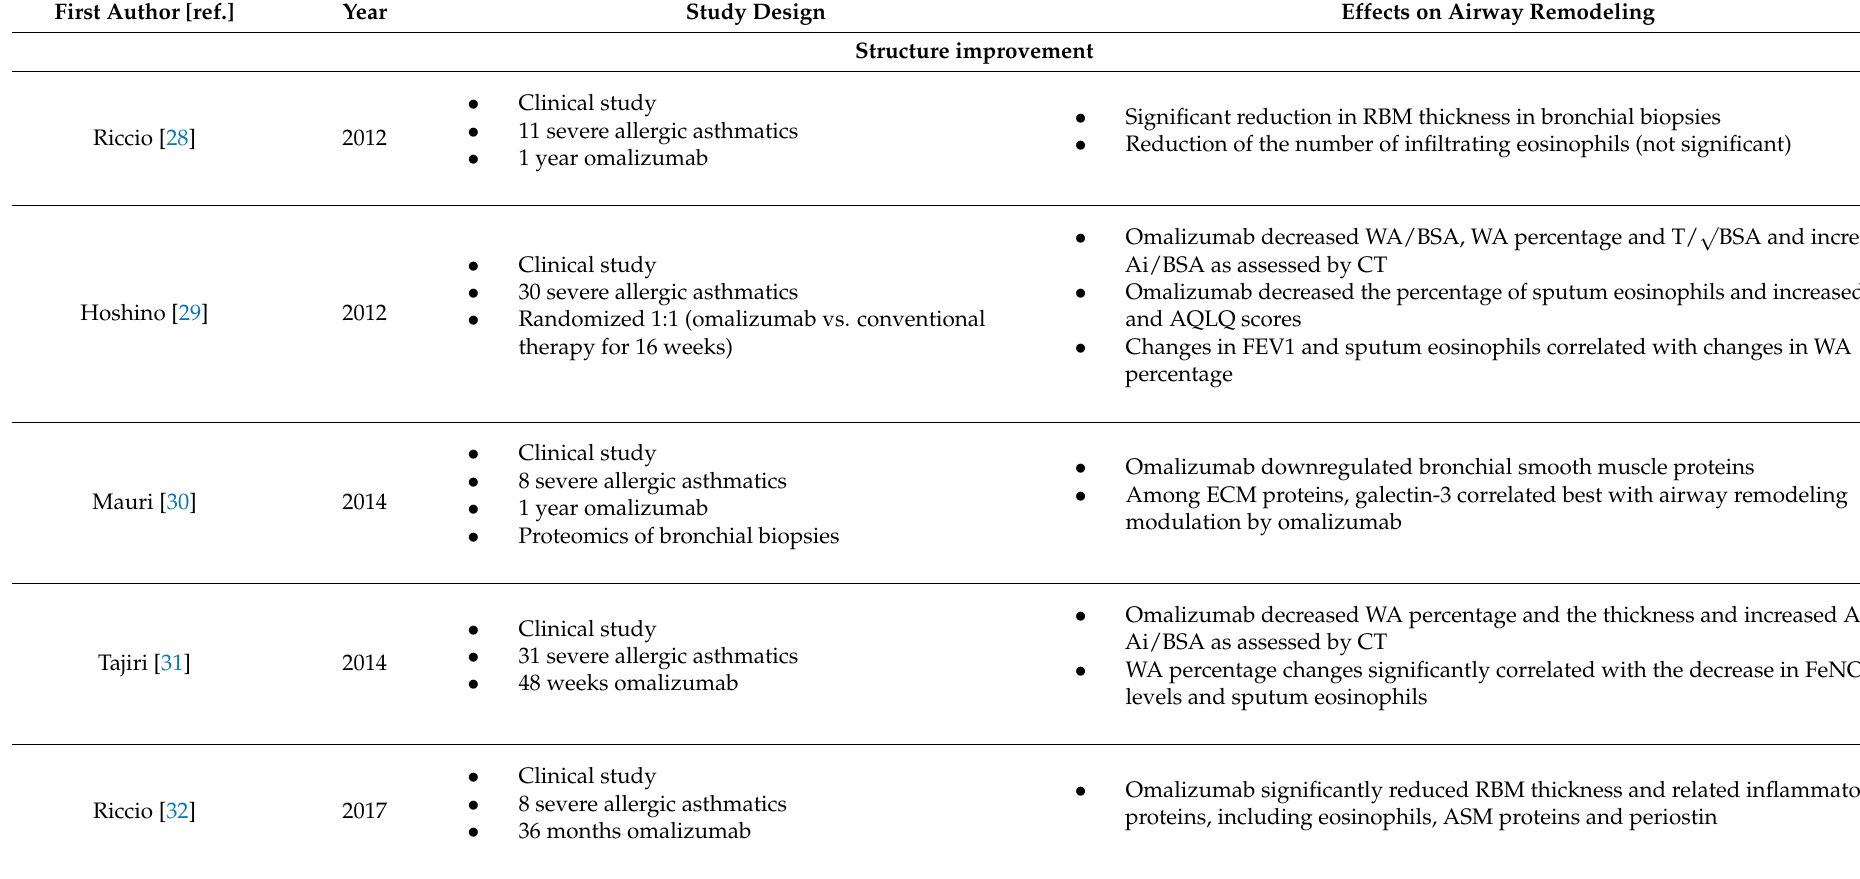
Table 2. Summary of omalizumab for the effects on airway